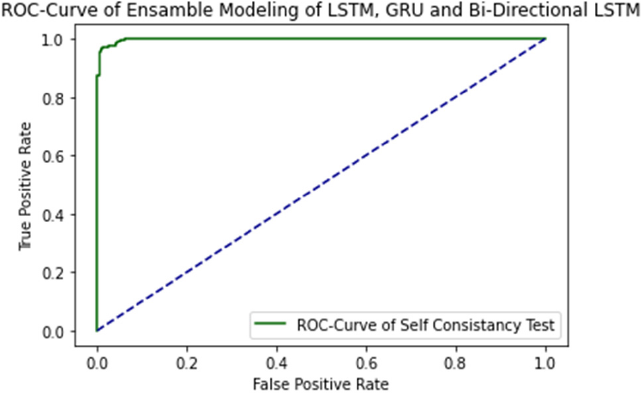
Figure 4. ROC Curve of proposed ensemble learning model with Self Consistency test. The AUC Value is 1.0, which is considered as excellent results according to AUC accuracy